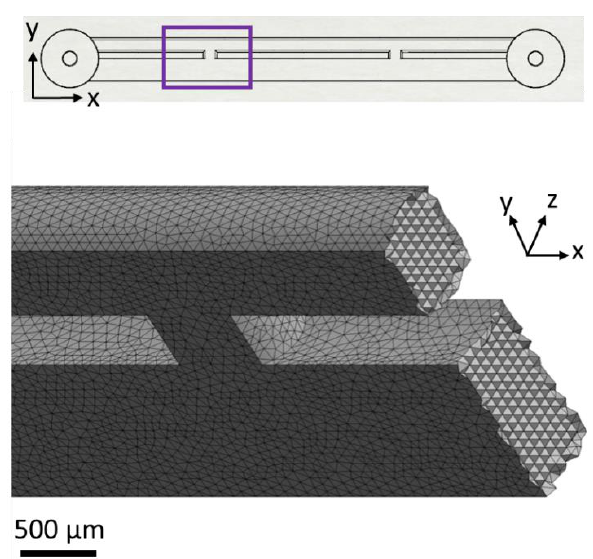
Figure A1. Illustration of the numerical mesh architecture. The mesh structure corresponds to a zoomed-in view of the optimum mesh size of 100 µm, generated using a patch independent method.